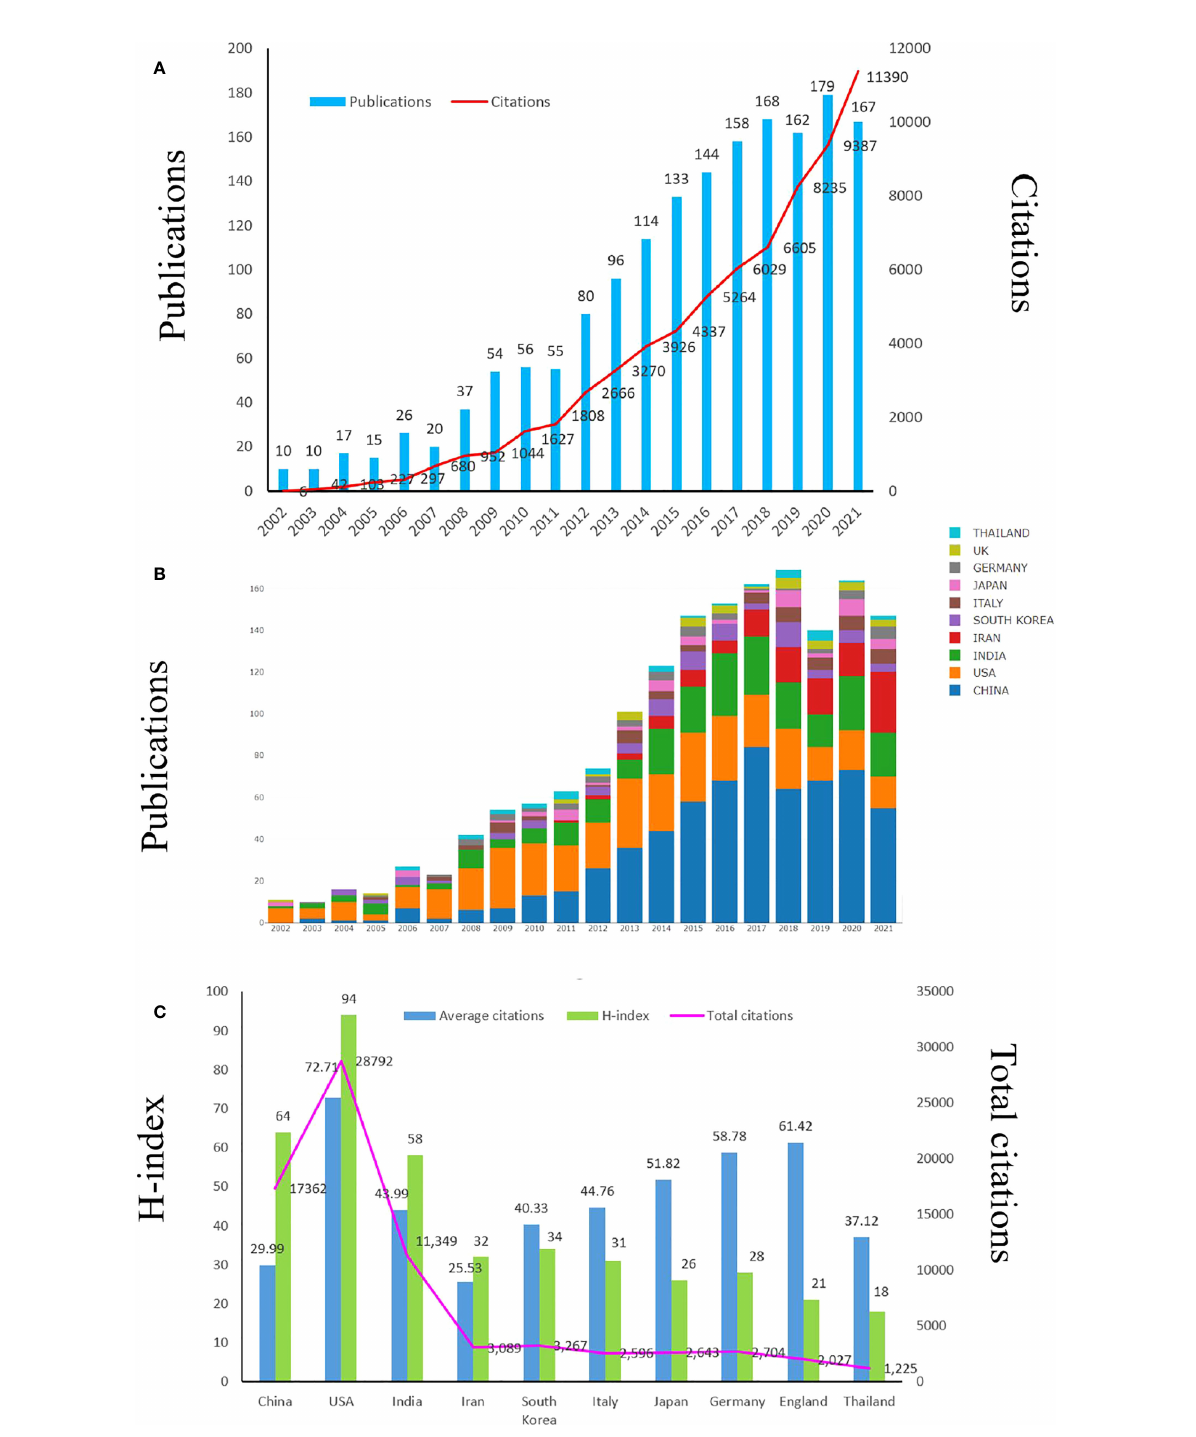
FIGURE 3 Global trends in publications about Curcumin and tumor. (A) The single-year publication numbers over the past 20years. (B) The annual worldwide publication output. (C) H-index, citations per article, and total number of citations for the top 10